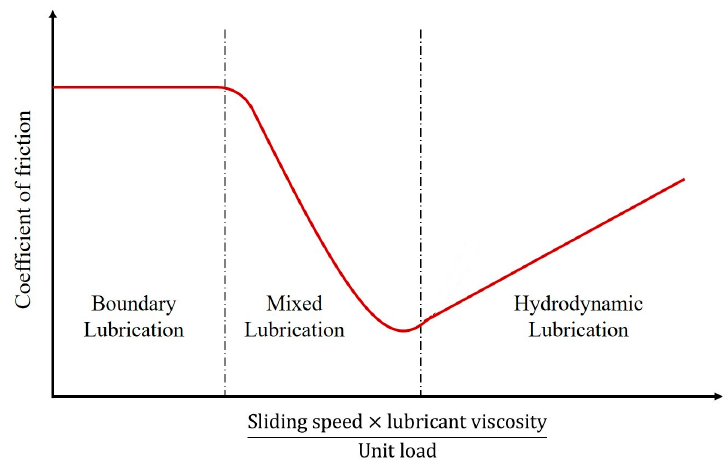
Figure 6. The Stribeck curve for fluid-lubricated contacts.